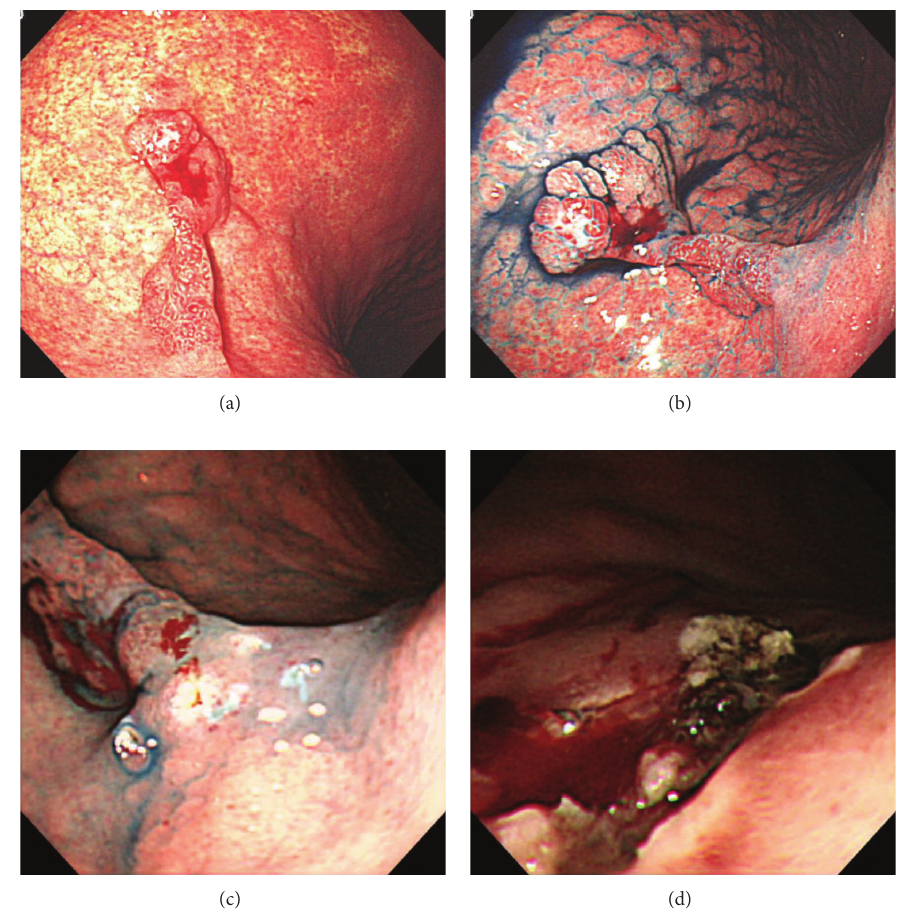
Figure 3: Case 2, endoscopic examination. EGD examination in October 2014, when an initial diagnosis of focal cancer within gastric HP was made ((a) white-light endoscopy; (b) white-light endoscopy with indigo-carmine dye staining). Endoscopic findings after en bloc resection by EMR (c, d). EGD: esophagogastroduodenoscopy; HP: hyperplastic polyp; EMR: endoscopic mucosal resection.